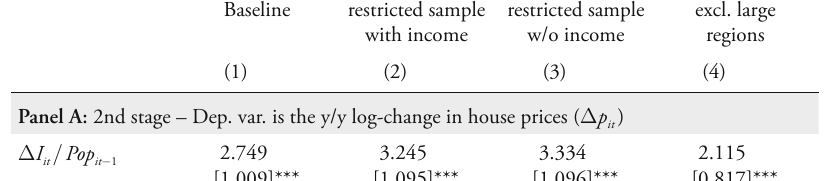
Table 4: IV Regressions for the y (cid:12) y Log-Change in House Prices ( (cid:27) p Baseline restricted sample restricted sample with income w/o income